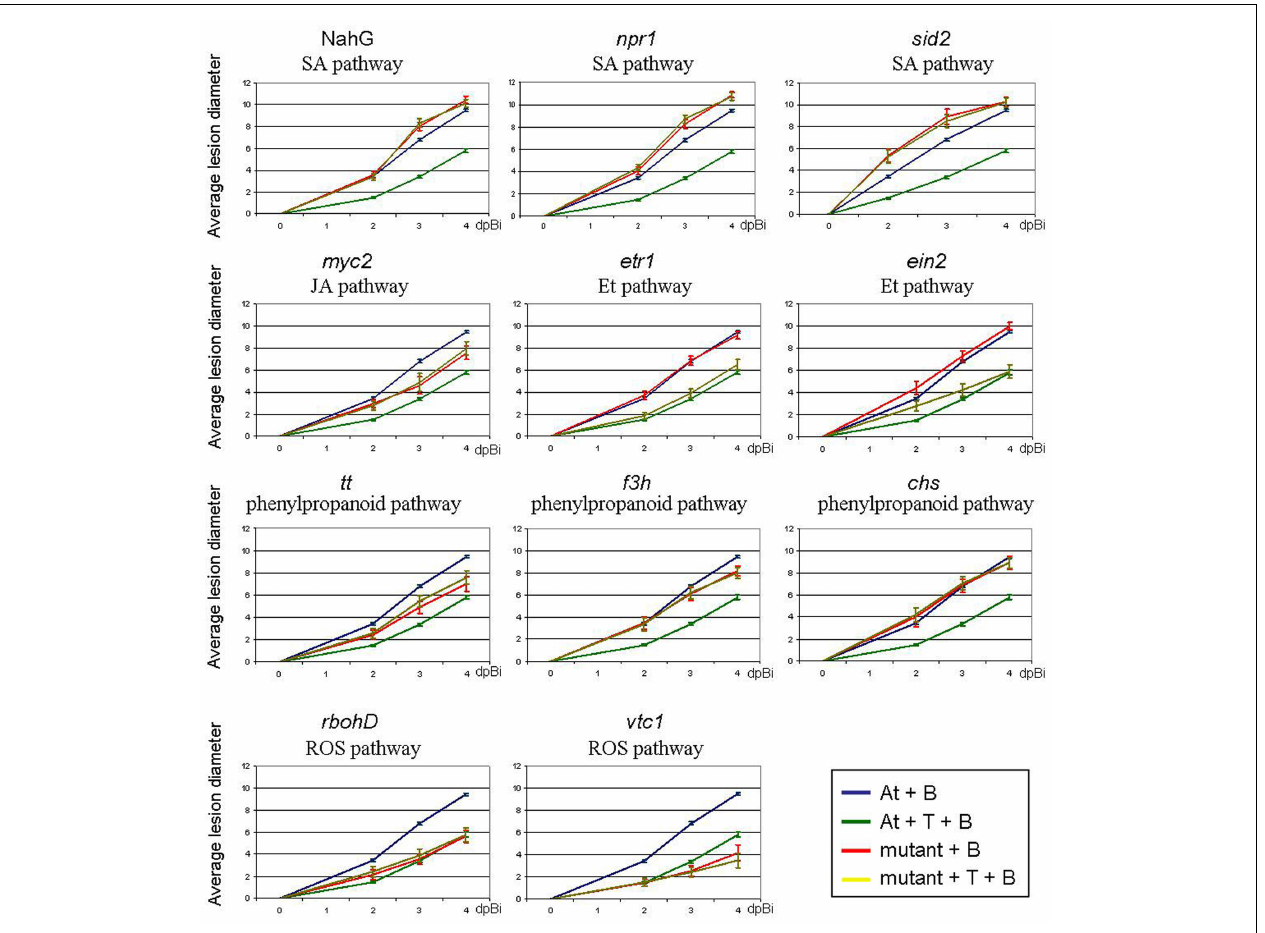
average lesion diameters and measured on 2, 3, and 4days post-inoculation (dpBi) with B. cinerea of mock-treated wild-type (blue) or mutant plants (red) and of T. hamatum T382 treated wild-type (dark green) and mutant plants (light green). Disease assays were repeated four to six times comprising a total of 100–250 plants depending on the mutant used. Confidence intervals (95%) are